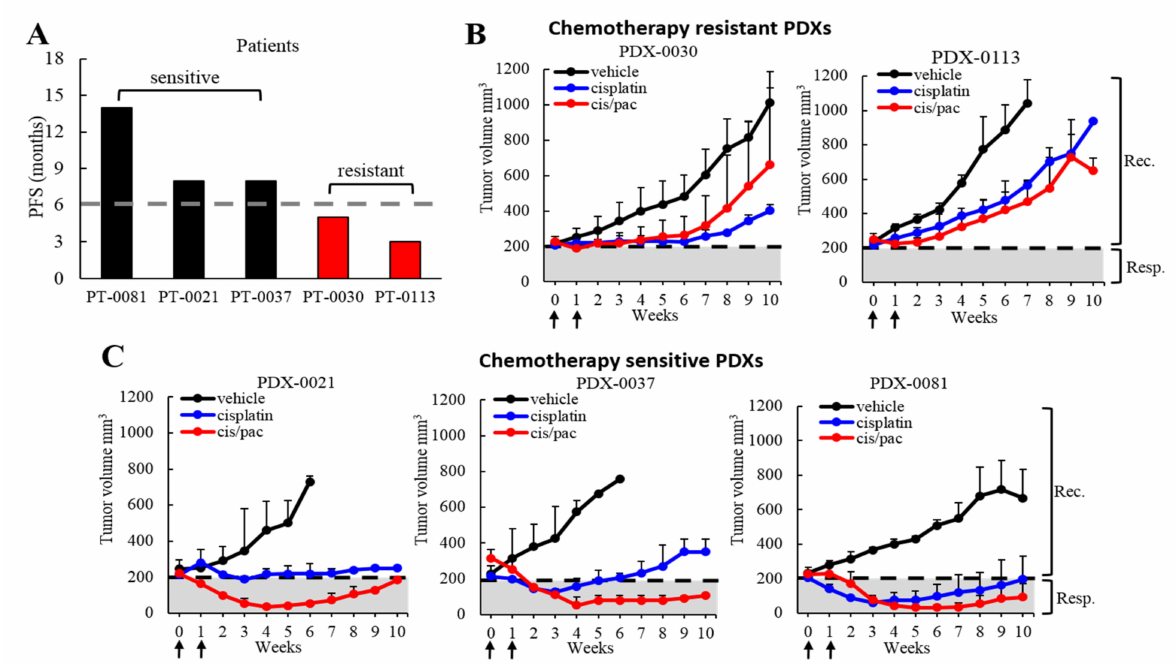
Figure 5. Assessment of the correlation in chemotherapy response between patients and their corresponding PDXs. ( A ) Clinical responses to platinum-based chemotherapy in patients determined by their progression-free survival (PFS). Platinum-sensitive ovarian cancer was categorized as a clinical response lasting at least six months following platinum therapy (PFS ≥ 6 months), while a platinum-resistant tumor was categorized as relapse within six months (PFS < 6 months). ( B ) Graphs show chemoresistant PDX growth rates and response to treatment. Mice received two doses of cisplatin or cisplatin+paclitaxel (arrows) or vehicle control. Rec. = recurrence, Resp. = response. ( C ) Graphs show chemosensitive PDX growth rates and response to